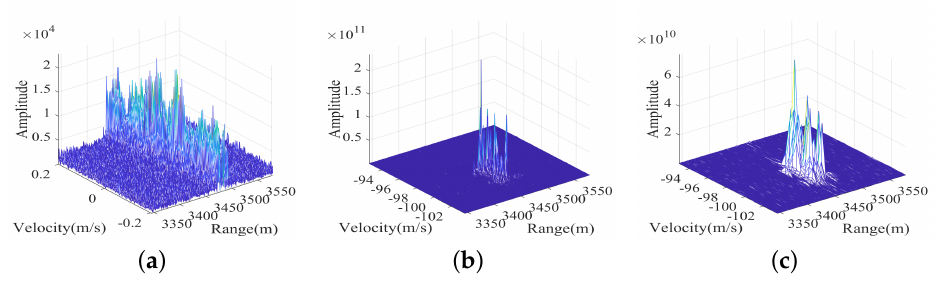
Figure 17. The range-velocity slices of GRFT and HGRFT for real data ( a ) Echo after pulse compres- sion. ( b ) The range-velocity slice of GRFT. ( c ) The range-velocity slice of